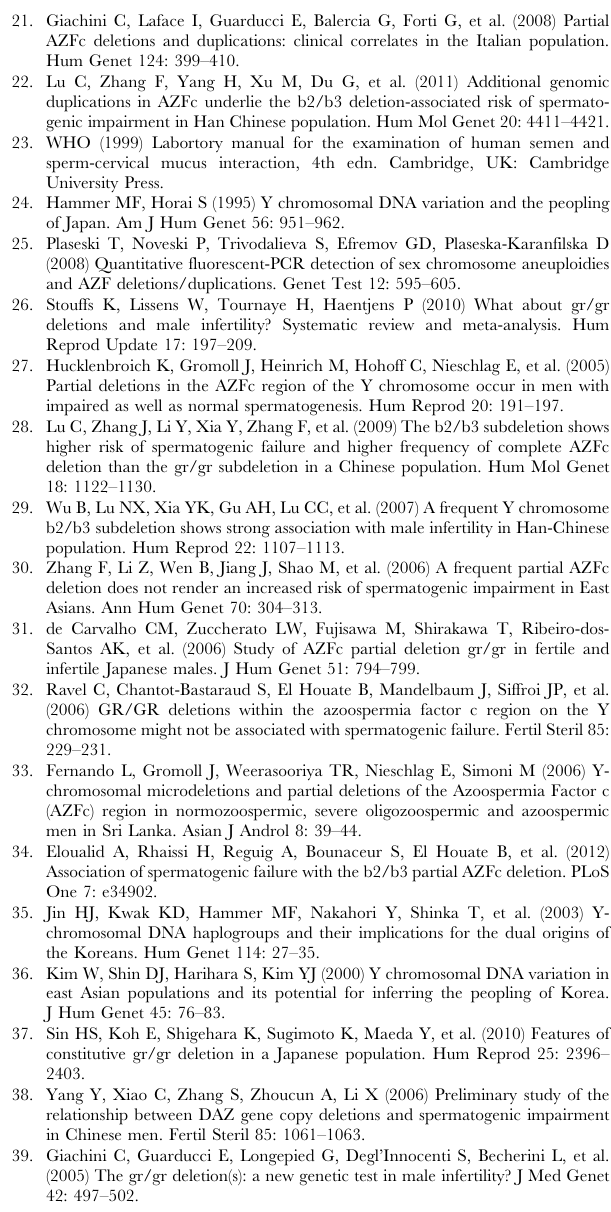
Table S1 Clinical features of patients bearing gr/gr deletions and their deletion patterns based on the type and number of DAZ - CDY 1copies deleted. Table S2 Means ± SD of the total sperm count, testicular volume and hormonal levels in patients and in